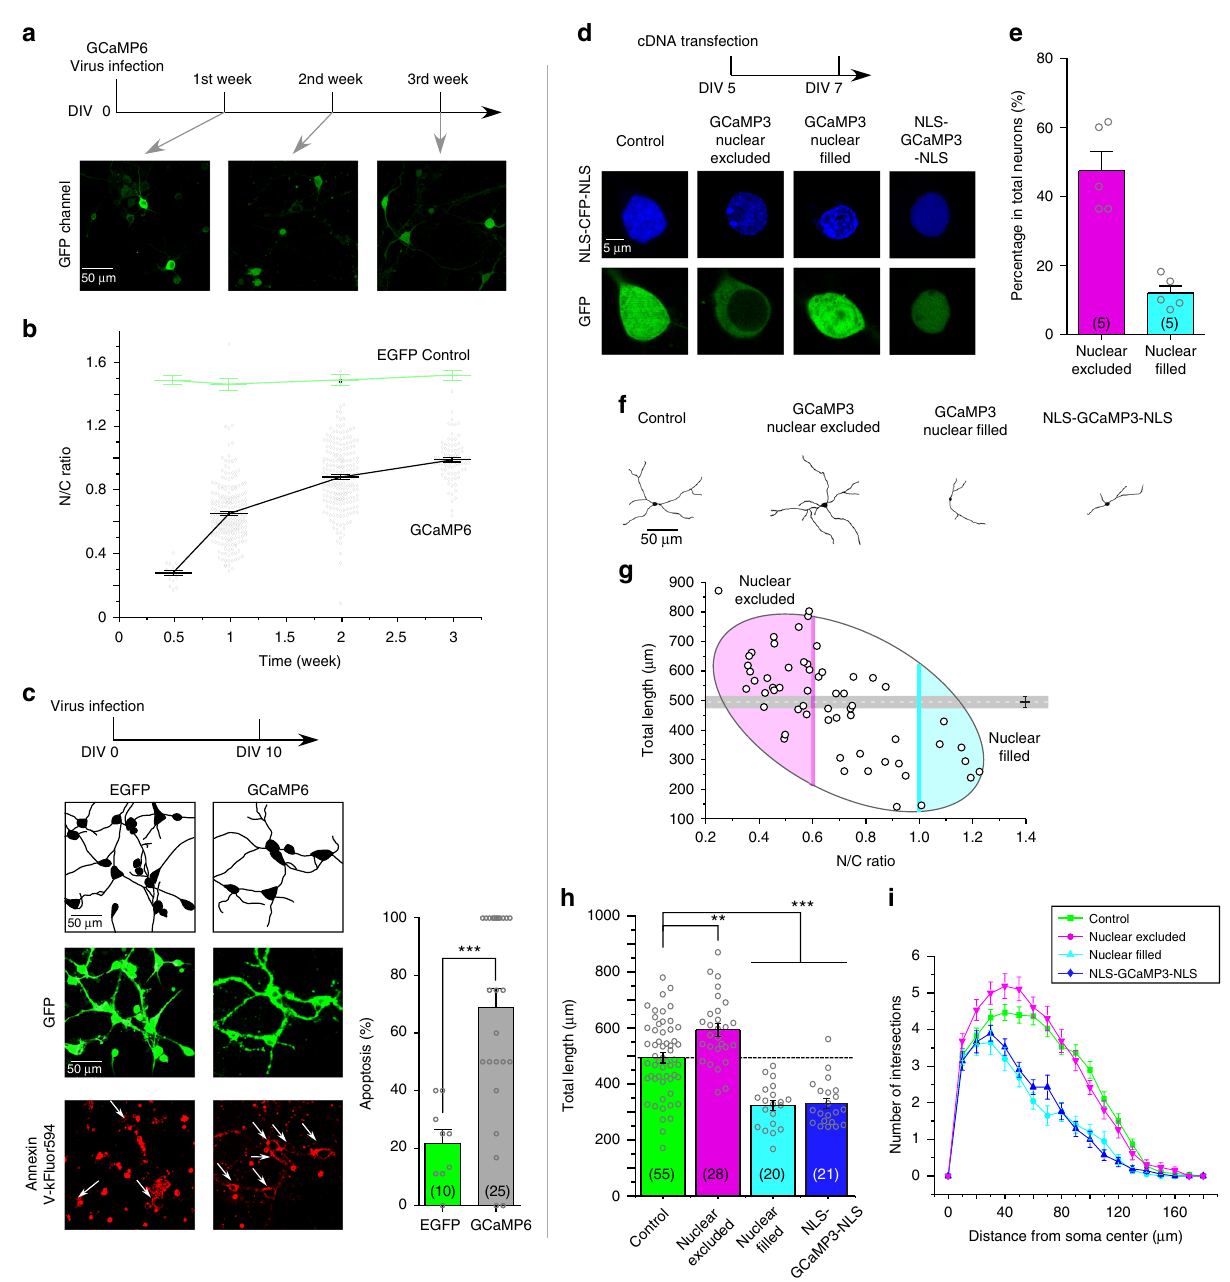
Fig. 1 Side-effects of GCaMP on cortical neurons. a Abnormal nuclear accumulation of GCaMP. Cultured cortical neurons infected with GCaMP6 (AAV- Syn -GCaMP6f) virus were examined with confocal live-cell imaging. b Analyses indexed with nuclear/cytosolic (N/C) fl uorescence ratio indicate time- dependent nuclear accumulation of GCaMP6, in contrast to stable GFP distribution. c GCaMP6 caused apoptosis. For cortical neurons infected with AAV- Syn -EGFP and AAV- Syn -GCaMP6f (green), tracing images of dendritic morphology (black and white) and confocal fl uorescence images of Annexin V- kFluor594 (red) are shown. Arrows are to identify apoptotic neurons where both green and red fl uorescence are present and the percentage of such neurons (per view) are counted (right, number of views in parentheses). d Subcellular distributions of YFP, GCaMP3 or NLS-GCaMP3-NLS overexpressed in cortical neurons. CFP fl uorescence (NLS-CFP-NLS, upper) indicates the nucleus (blue) in cortical neurons. GFP images (lower row) of neurons expressing GCaMP3 (2 days after cDNA transfection) could be categorized into two major subgroups of interest: nuclear-excluded (N/C ratio < 0.6) and nuclear- fi lled (N/C ratio > 1.0), with the latter mimicked by neurons expressing NLS-GCaMP3-NLS. Such criteria (N/C ratio < 0.6 and >1) were applied throughout this study (unless indicated otherwise). e Based on the above criteria neurons of nuclear- fi lled group and nuclear-excluded group accounted for ~10% and ~50% of the total number of GCaMP3-expressing neurons, respectively (5 experiments). f Representative images tracing neurite morphology for cortical neurons from different subgroups. g Correlations between N/C ratio of GCaMP3 and neurite outgrowth. The grey line/area represents the total neurite length per neuron (control group). The eclipse enclosing most neurons contains two major areas representing the subgroups of nuclear- fi lled (cyan) and nuclear-excluded (pink). Nuclear GCaMP accumulation (N/C ratio) and neurite outgrowth (neurite length per neuron) are highly correlated (the correlation coef fi cient is − 0.7). h , i Additional experiments and analyses for neurite morphology. Neurite outgrowth was quanti fi ed for the four subgroups by neurite length ( h ) and Sholl analysis ( i ), with the total number of cells in parentheses. Standard error of the mean (S.E.M.) and Student ’ s t - test (two-tailed unpaired with criteria of signi fi cance: * p < 0.05; ** p < 0.01, and p < 0.001) were calculated when